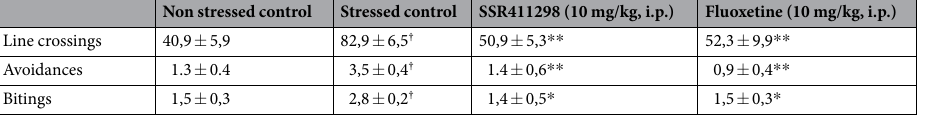
Table 3. Effects of repeated administration of SSR411298 and the antidepressant fluoxetine for 33 days on chronic mild stress-induced anxiogenic-like behaviors in the mouse defense test battery. Data represent mean ± SEM; ** P < 0.01 (vs. stressed control, Kruskal-Wallis or Dunnett’s t-test); † P < 0.01 (vs . non stressed mice, Wilcoxon test). N = 14 to